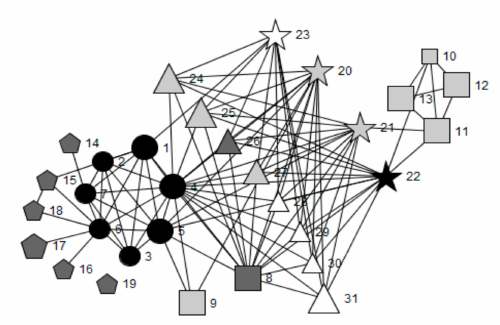
Figure 4. Net-map of wellbeing lead’s ego network for Woodlands School.